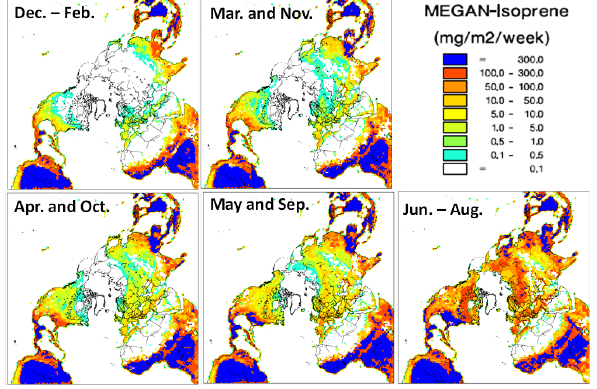
Figure 2. Spatial distribution of the simulated isoprene emission from the MEGAN model for the year 2008. Months with similar emissions are represented by the same map. Figure 3. Spatial distribution of the simulated monoterpene emis- sion from the MEGAN model during the year of